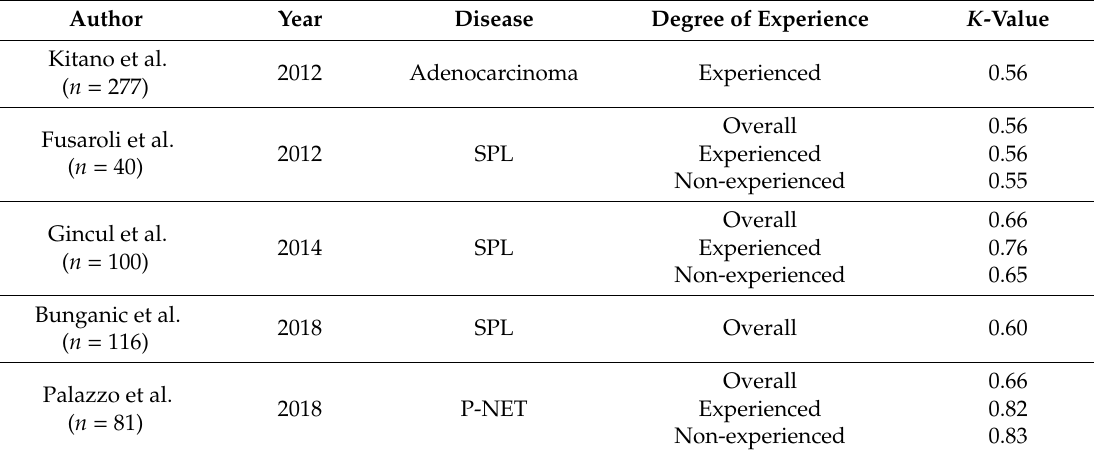
Table 2. Interobserver reliability of contrast-enhanced harmonic endoscopic ultrasonography (CH-EUS) criteria in solid pancreatic